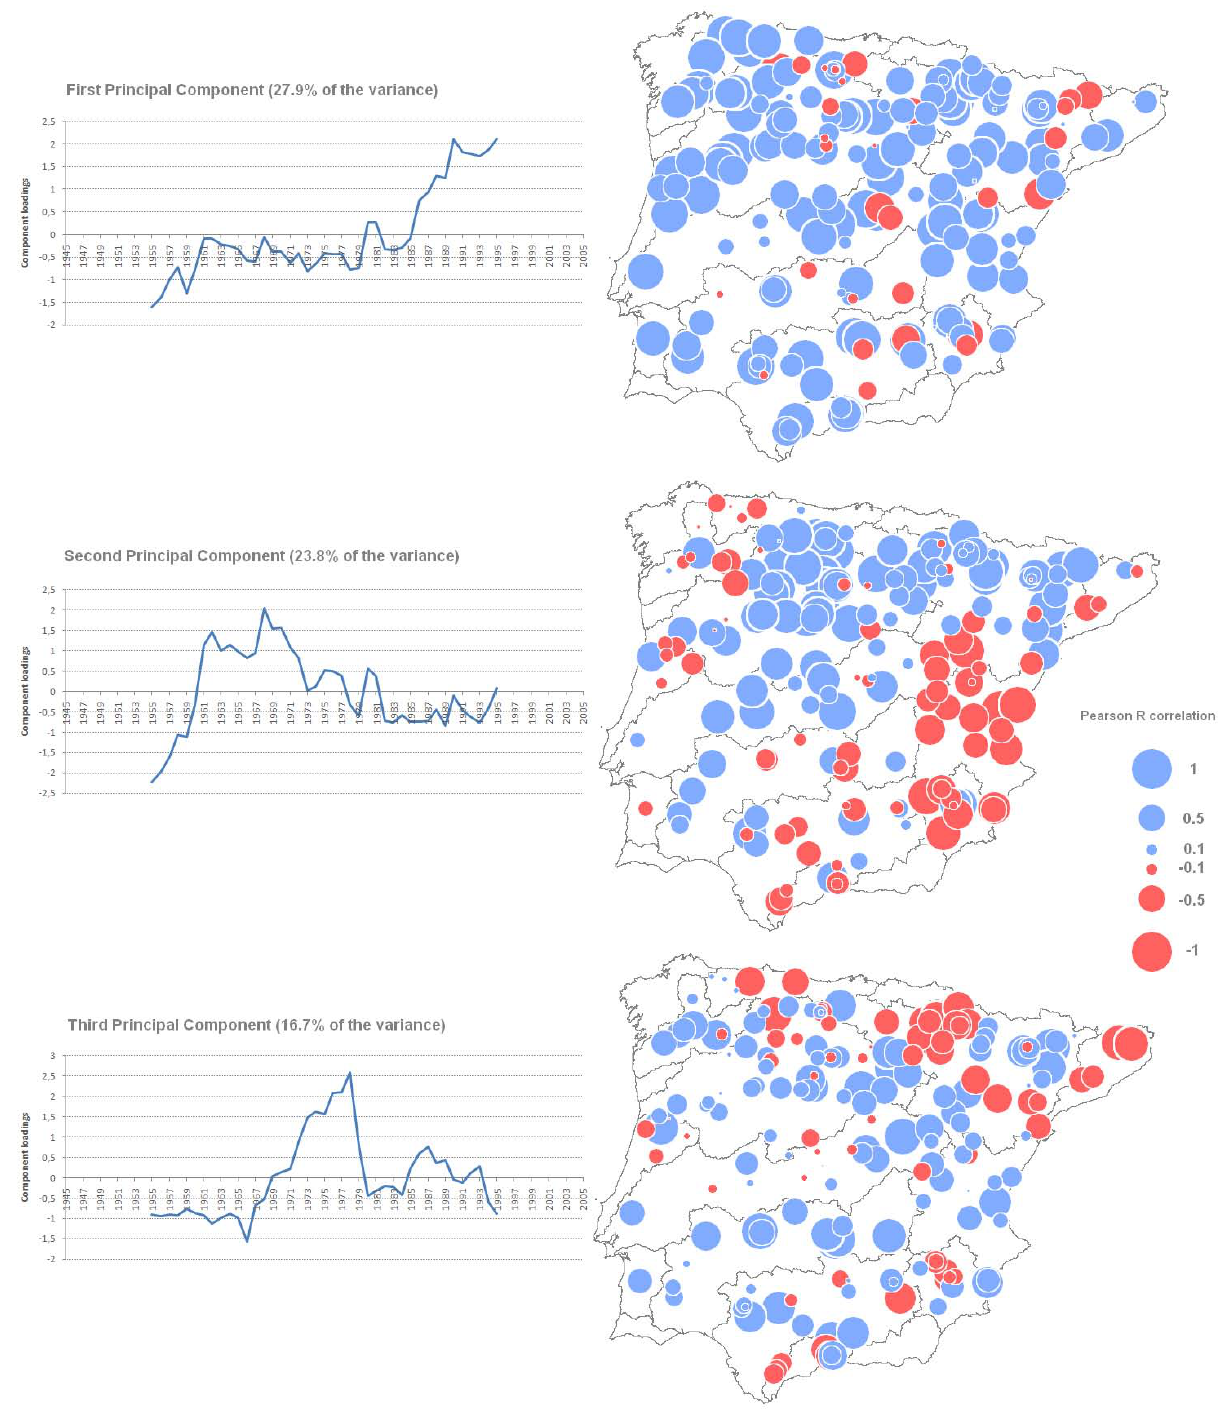
Fig. 7. The scores of the three first Principal Components extracted from the moving-window (21yr) correlation series between the monthly Winter NAO index and the monthly March SSI’s (left column). Spatial distribution of the correlation coefficients between the scores of the Principal Components and the original moving correlations between the monthly Winter NAO index and the monthly March SSI’s obtained at every gauging station (right